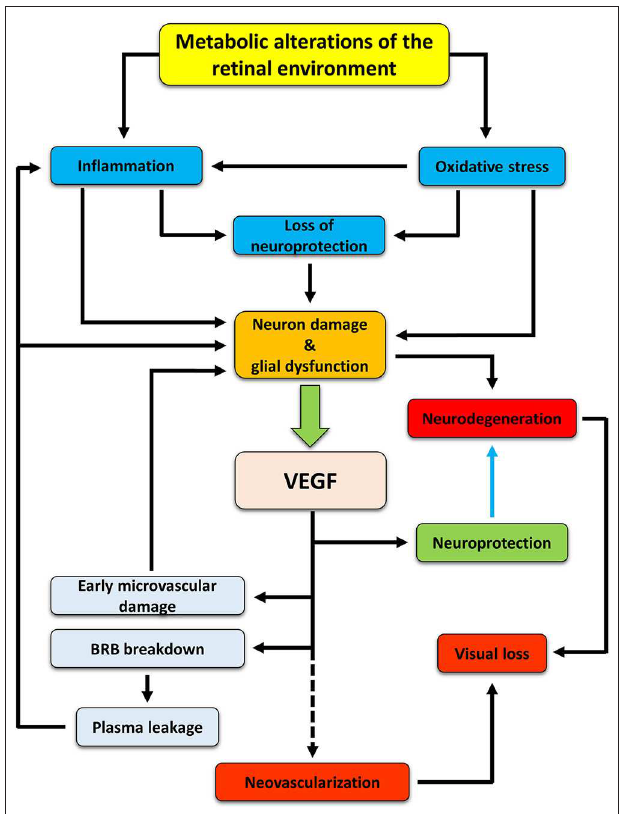
FIGURE 1 | Hypothetic cascade of events occurring in the retina during diabetes and leading to the development of DR. Hyperglycemia induces metabolic changes in the retinal milieu, leading to oxidative stress and inflammation. Oxidative and inflammatory processes cause damages to neuron and glial cells both directly and indirectly by inducing alterations in the production and release of neurotrophic factors. As a consequence, neurodegenerative processes are activated. In an attempt to protect themselves, suffering neurons would trigger production and release of VEGF, mainly by Müller cells, that may act as a neuroprotectant, thus counteracting neurodegeneration (blue arrow). However, if in the early phases of DR VEGF may act as a neuroprotective factor, its prolonged release triggers vascular damages (which, in turn, may reinforce in a different fashion inflammation and retinal damage), ultimately leading to new vessel proliferation. If untreated, neurodegenerative and neovascular processes concur to visual dysfunction, finally leading to vision